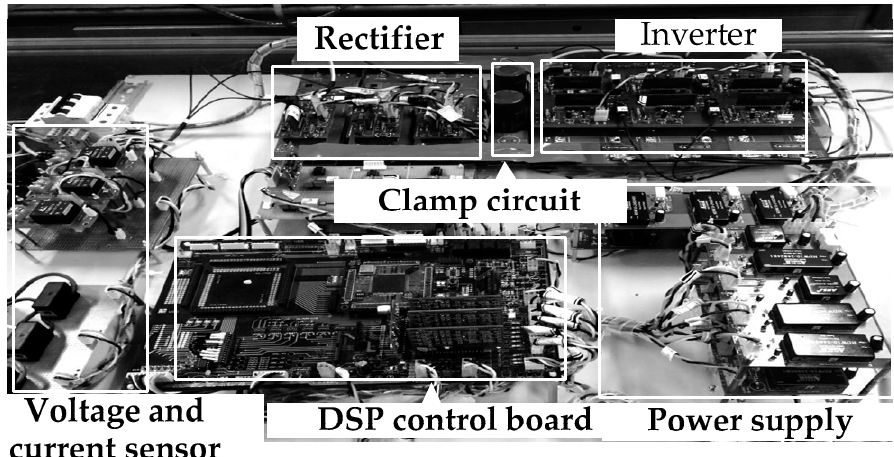
Figure 7. Experimental system of ultra-sparse matrix converter (USMC).